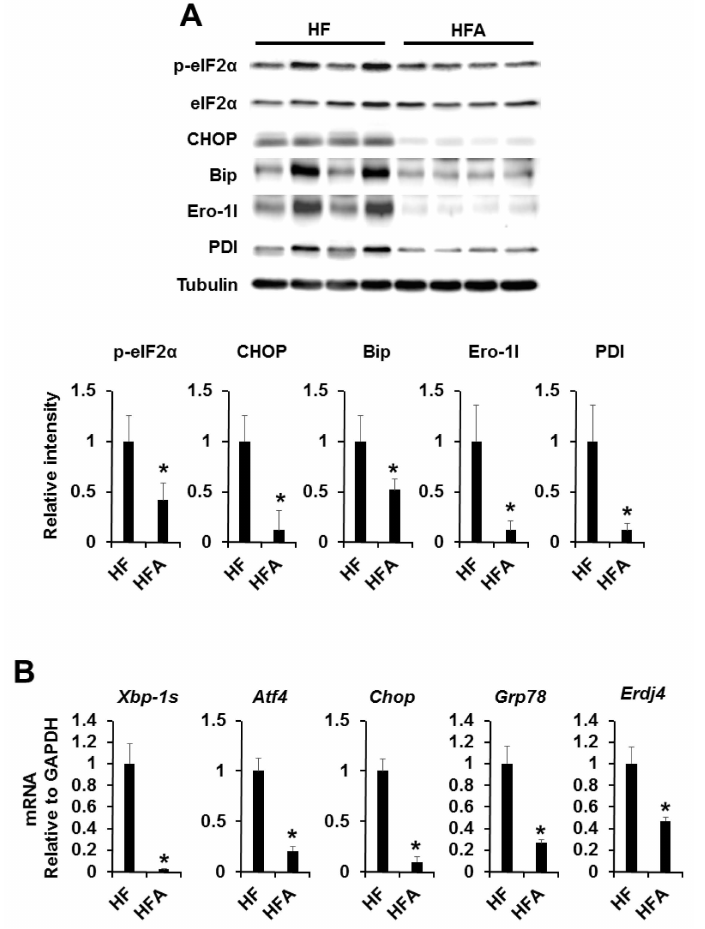
Figure 3. Effects of central administration of ADE on ER stress responsive markers and ER chaperone/foldases expression. ( A ) Effects of ICV administration of ADE (1 µ L of 10 mg/mL) on hypothalamic ER stress responsive markers and ER chaperone/foldases. The results of densitometric analysis ( lower ) are means ˘ SDs ( n = 10); * p values of < 0.05 indicate significant difference from administration with DMSO (1 µ L of 20% DMSO); ( B ) Effects of ICV administration of ADE (1 µ L of 10 mg/mL) on hypothalamic mRNA expression levels of hypothalamic ER stress responsive markers. The results are means ˘ SDs ( n = 10 per group); * p values of < 0.05 indicate significant difference